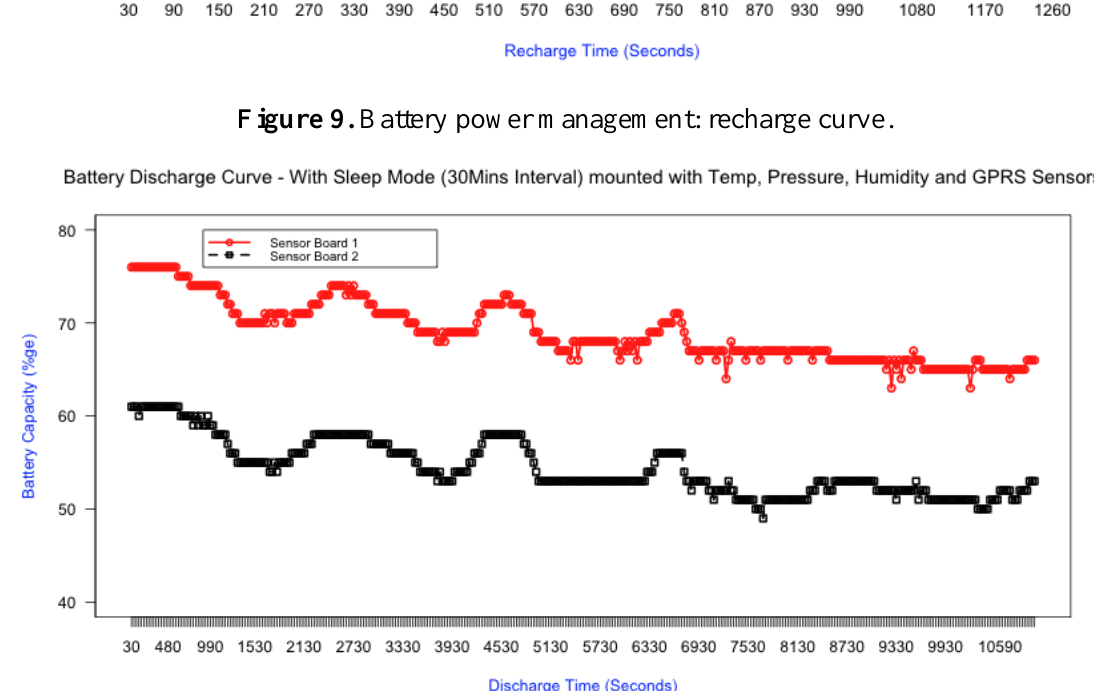
Figure 10. Battery power management: discharge